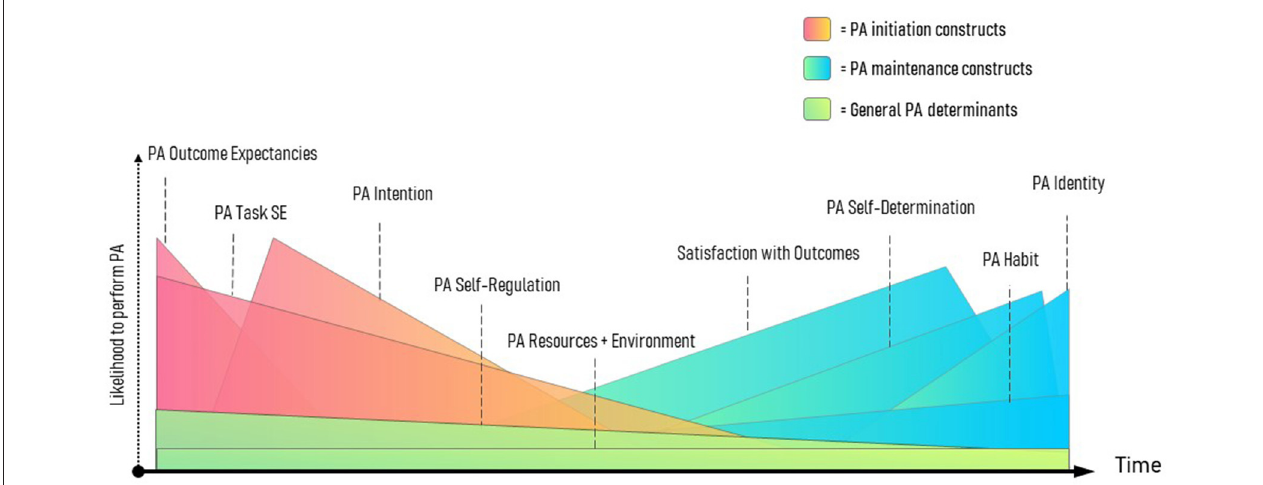
FIGURE 2 | Proposed pattern of physical activity initiation, general determination, and maintenance and associated constructs. Constructs are mere prototype examples and not established in this